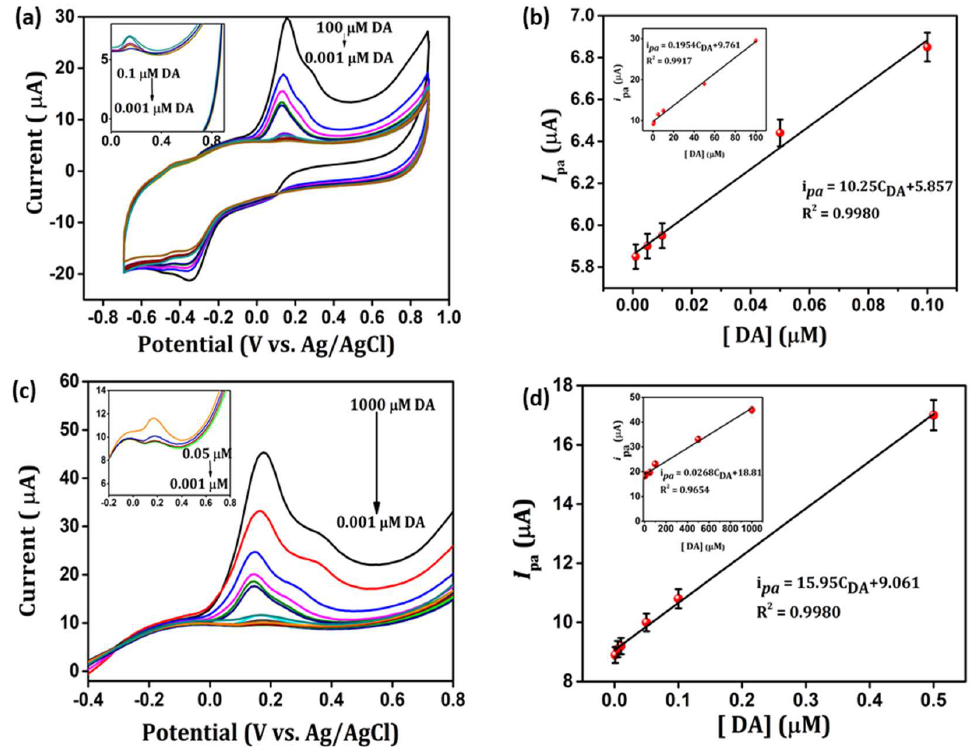
Figure 6. ( a ) CVs of DA at N-GQDs/GCE for concentrations from 0.001 to 100 µ M and inset of ( a ) include concentrations from 0.001 to 0.1 µ M. ( b ) The calibration curve of DA from CV response in the linear range (0.001 → 100 µ M) at N-GQDs/GCE and inset of ( b ) include linear range 0.001–0.1 µ M. ( c ) LSVs of DA at N-GQDs/GCE for concentrations from 0.001 to 100 µ M and inset of ( c ) includes concentrations from 0.001 to 0.1 µ M. ( d ) The calibration curve of DA from LSV response in the linear range (0.001 → 100 µ M) at N-GQDs/GCE and inset of ( b ) include linear range 0.001–0.1 µ M.